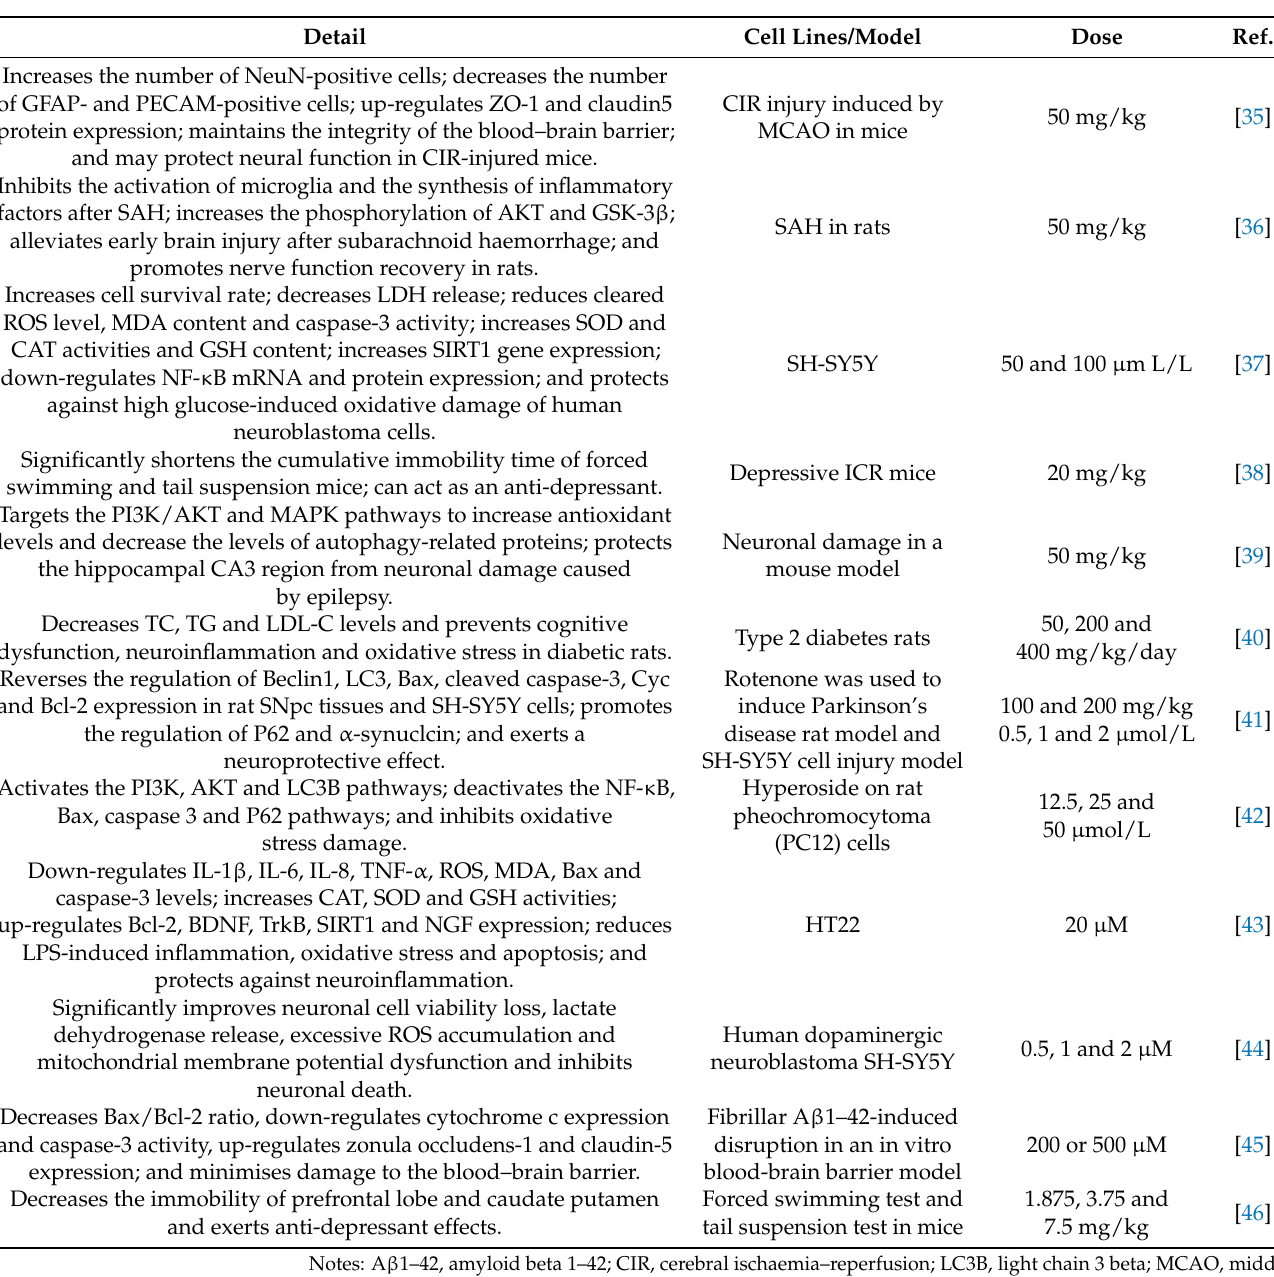
Table 2. Neuroprotective Activity of